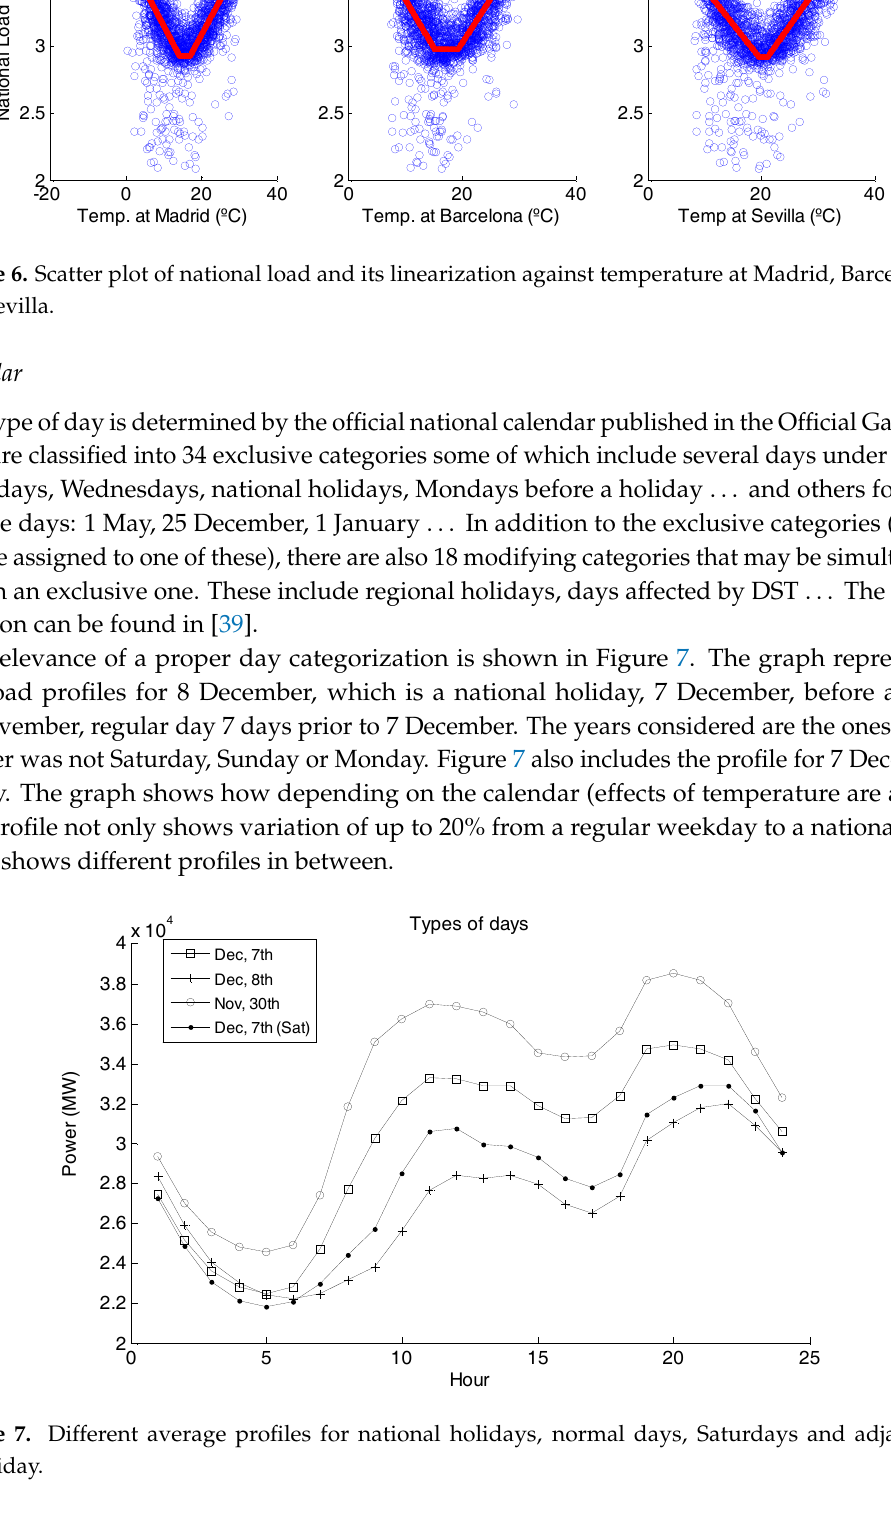
Figure 7. Different average profiles for national holidays, normal days, Saturdays and adjacent to holiday.